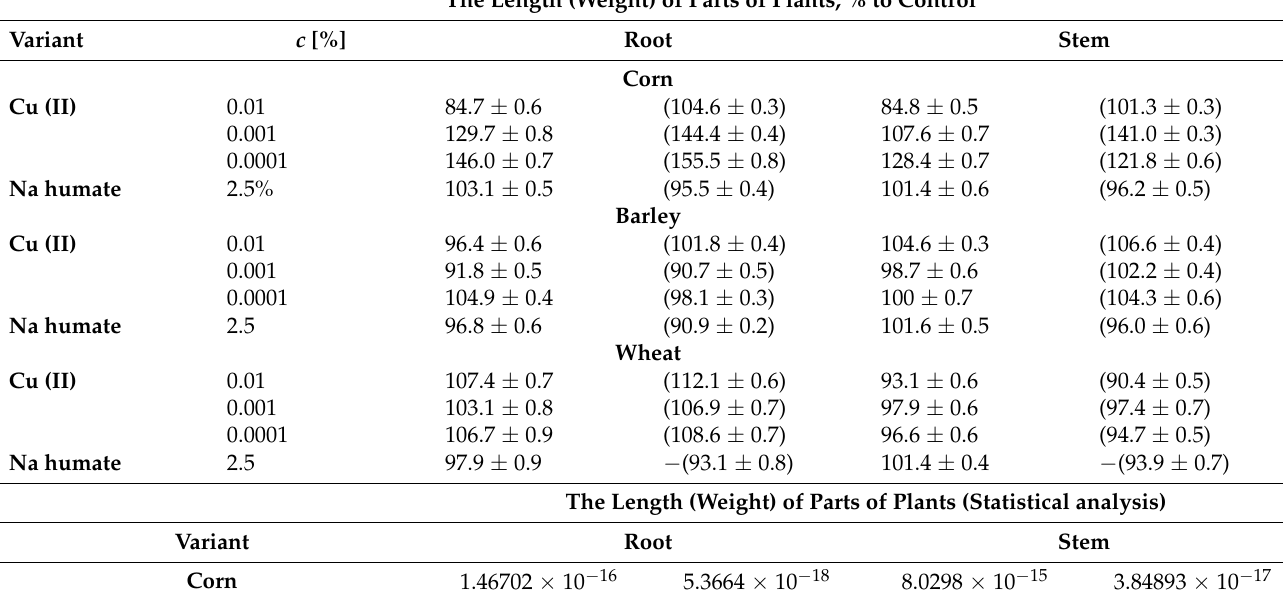
Table 1. Growth-regulating activity of trans-diaqua-trans-bis [1-hydroxy-1,2-di (methoxycarbonyl) ethenato] copper ( n = 30). The seeds grown or soaked in water were as a control. A 2.5% sodium humate solution was used as a standard. c denotes concentration. Values of the deviation probabilities of the null hypothesis P, obtained from the data for Cu (II) in the concentrations 0.01, 0.001, and 0.0001%, Na humate 2.5% to the control